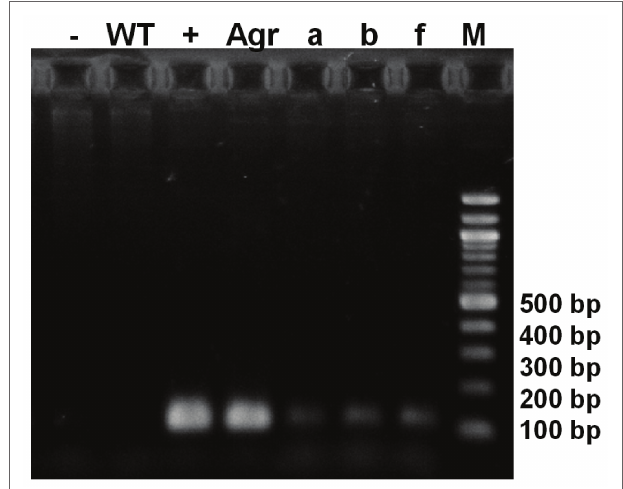
FIGURE 2 | PCR assay for the detection of EB peptide gene in nucleus transformed microalgae. Amplification of an expected 116-bp product corresponding to the EB gene of nuclear transgenic lines (a, b, f), (Agr): Positive control EB-pChlamy_1 purified from Agrobacterium tumefaciens ; (+): Positive control EB-pChlamy_1 purified from E. coli ; ( − ): negative control; (WT): wild type strain DNA; (M) DNA molecular weight marker (100 bp